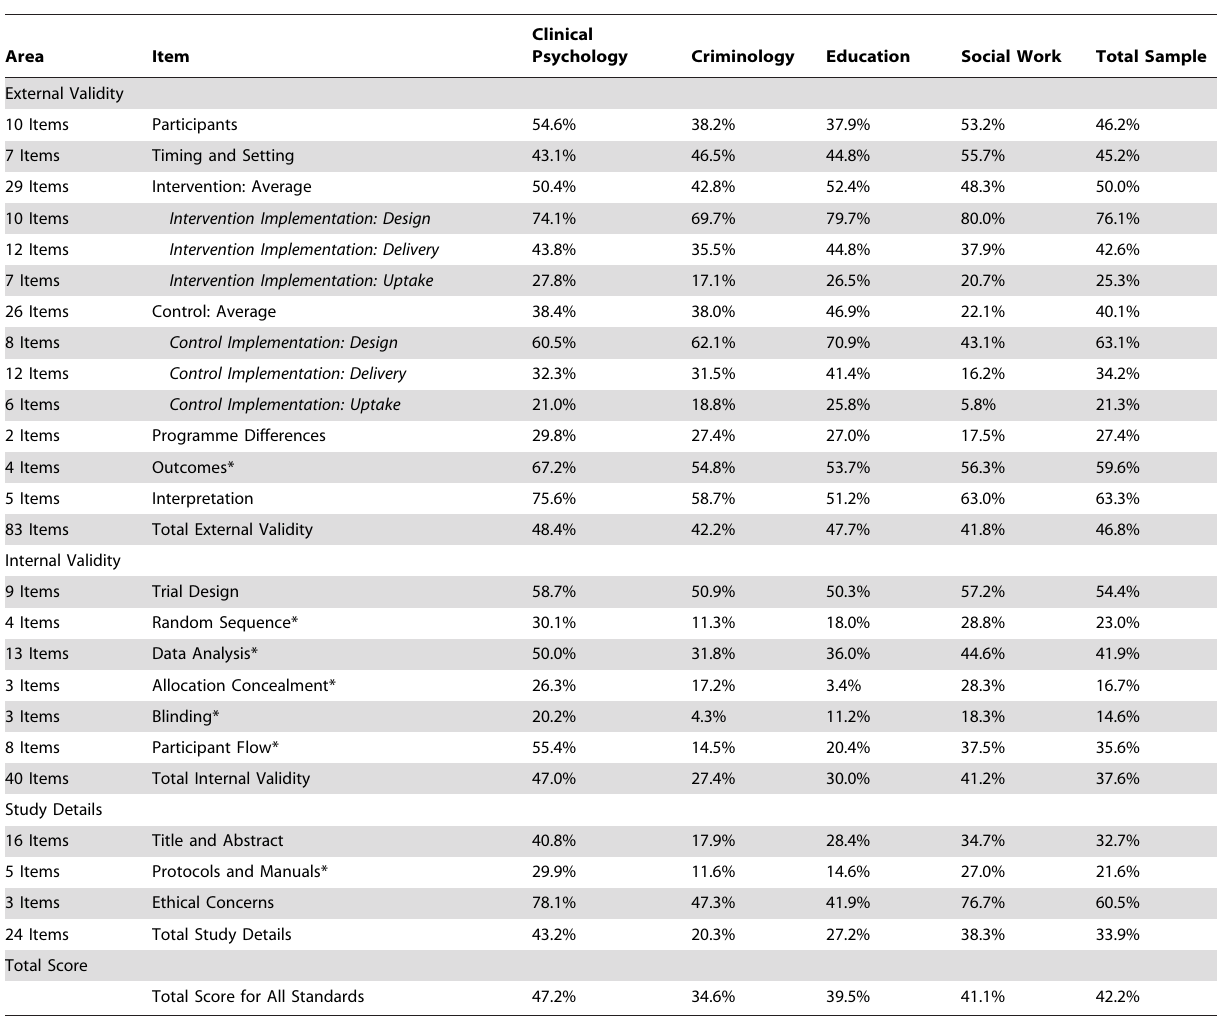
Table 4. Average compliance of RCTs with reporting